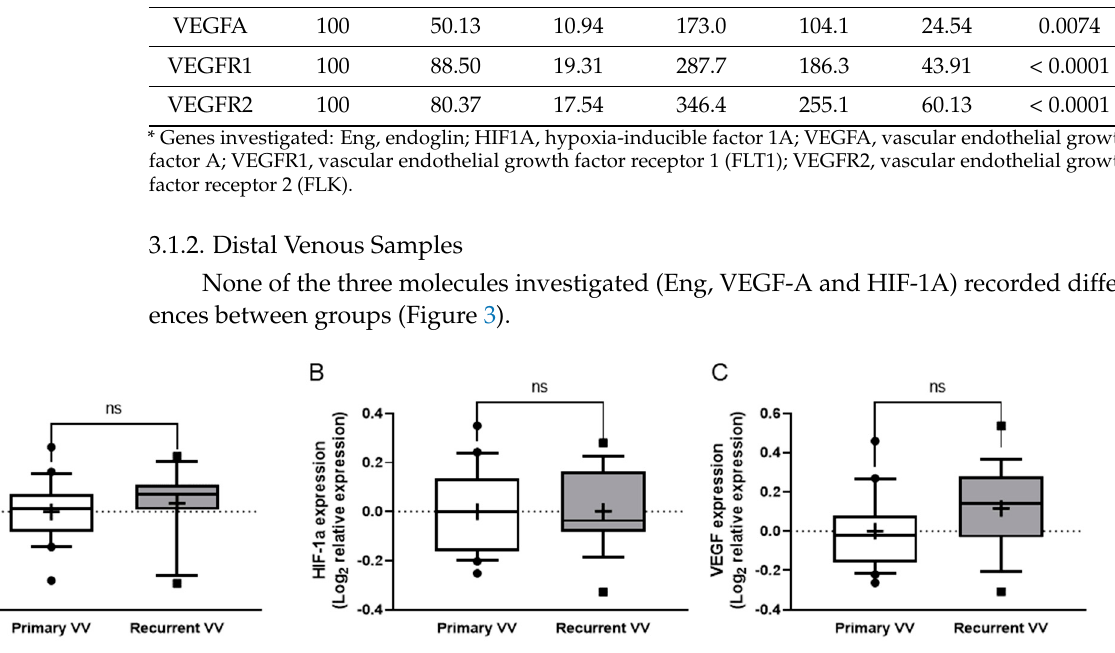
Table 2. Expression (%) of the genes investigated in samples of the proximal internal saphenous vein. Primary Varicose Veins Recurrent Varicose Veins Genes * Mean SD SEM Mean